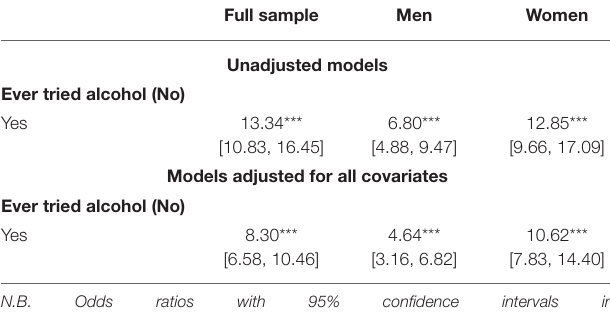
TABLE 4 | Association between ever trying alcohol drinking and tobacco